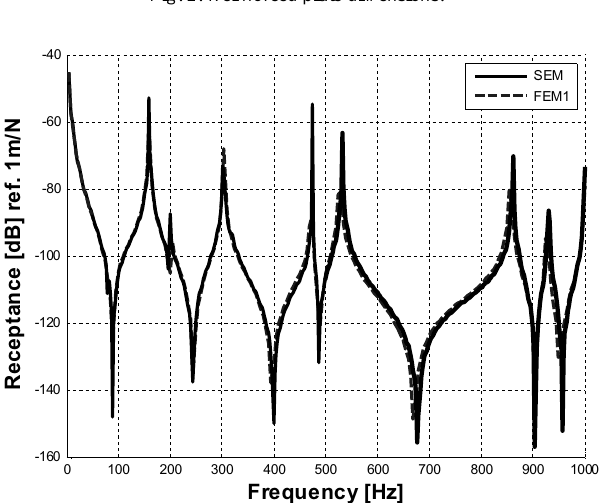
Fig. 3. FRFs obtained with SEM and FEM1 models for a frequency range 0–1